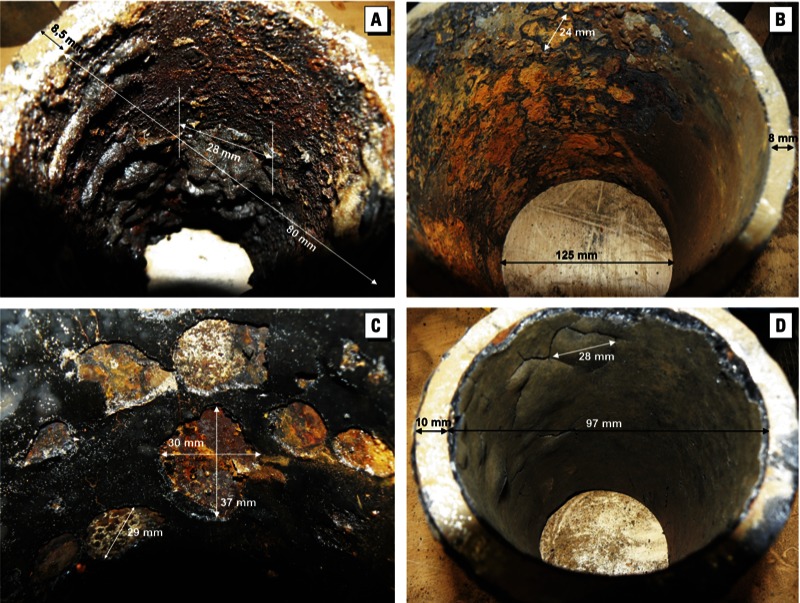
Photographs showing coating of of water main segments from (A) location 104: 0% coal tar coating; (B) location 41: > 0 to 50% bitumen coating (thin); (C) location 83: > 50 to < 100% bitumen coating (thick); and (D) location 34: 100% bitumen coating (thick).